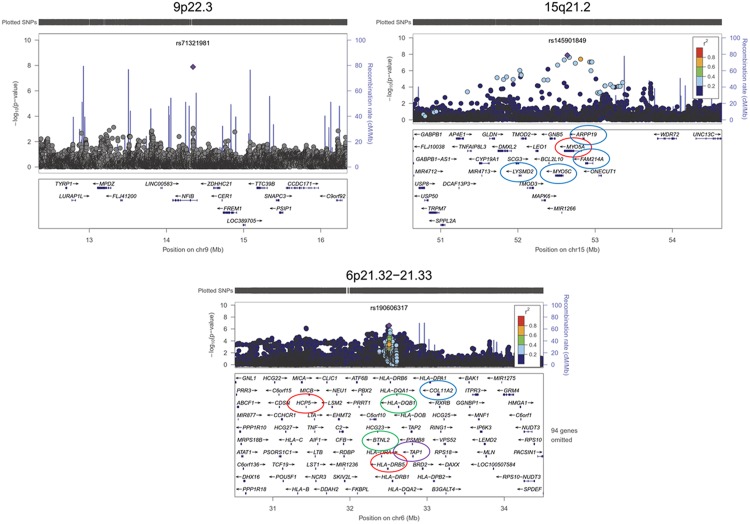
Regional association plots for associated loci in the GWAS meta-analysis of sciatica.The associations along with recombination rates and genes on the region are shown in 2 Mb windows surrounding the lead SNP, to provide a graphical view of the associated region. SNPs are plotted by position on chromosome (x-axis) against association with sciatica (-log10 –p-value, y-axis). The lead SNP is shown with a purple diamond. Color intensity of each dot depicting a SNP reflects the extent of LD with the lead SNP, colored red (r2<0.8) through blue (r2<0.2). The LD has been estimated using 1000 Genomes, Mar2012 release, European population (see URLs). Physical positions are based on of the human genome build 37 (NCBI). 9p22.3: (NFIB) represented by rs71321981 (chr9:14344410:I, p = 1.30x10-8). No usable LD information was available for this SNP. 15q21.2: (MYO5A) represented by rs145901849 (p = 1.34x10-8). The associated region harbor SNPs in the MYO5A (p < 5x10-8) (red circle) and SNPs in the surrounding genes MYO5C, LYSMD2, ARPP19, and FAM214A (p<1.0x10-6) (blue circles). 6p21.32: (HLA-DRB5) represented by rs115488695 (p = 3.58x10-7). The HLA gene region (6p21.32) has previously been associated with musculoskeletal disorders; SNPs (rs2187689, rs7767277) nearby TAP1 (violet circle) were associated with lumbar disc degeneration in the meta-analysis of Northern European individuals [26], two SNPs (rs7775228, rs10947262) within BTNL2 and nearby HLA-DQB1 genes (green circles) were associated with knee osteoarthritis in a Japanese GWAS [27), and two SNPs (rs2076311 and rs1799907) within COL11A2 (blue circle) were associated with magnetic resonance-determined disc signal intensity [28], and with degenerative lumbar spinal stenosis with radicular pain in Finnish individuals [29].